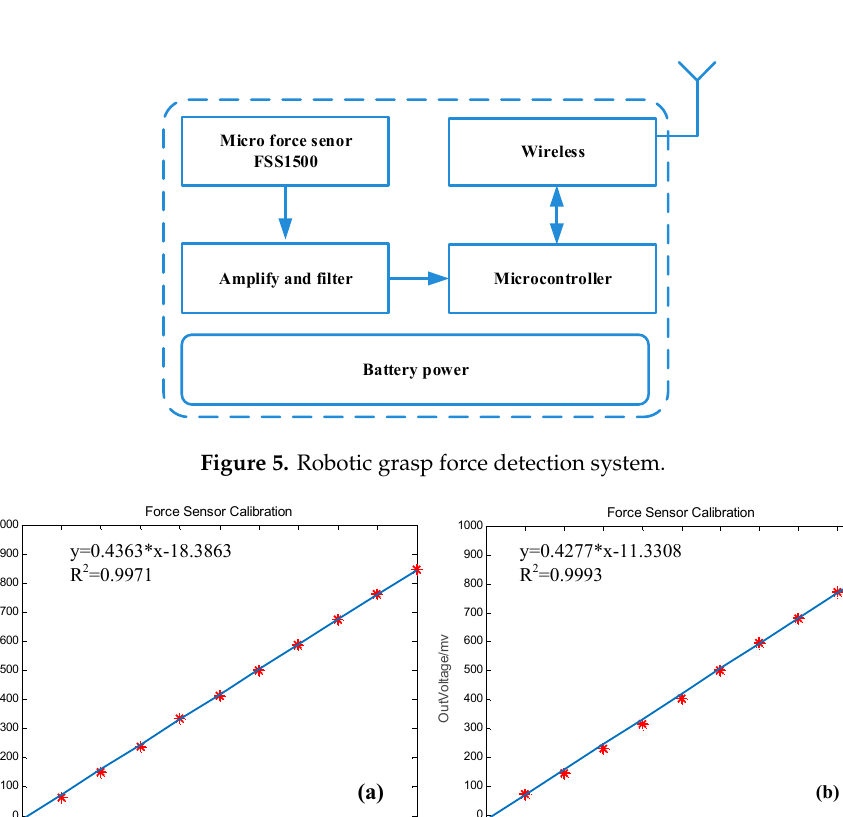
Figure 6. Calibration of left ( a ) and right ( b ) force sensors of the robot gripper.